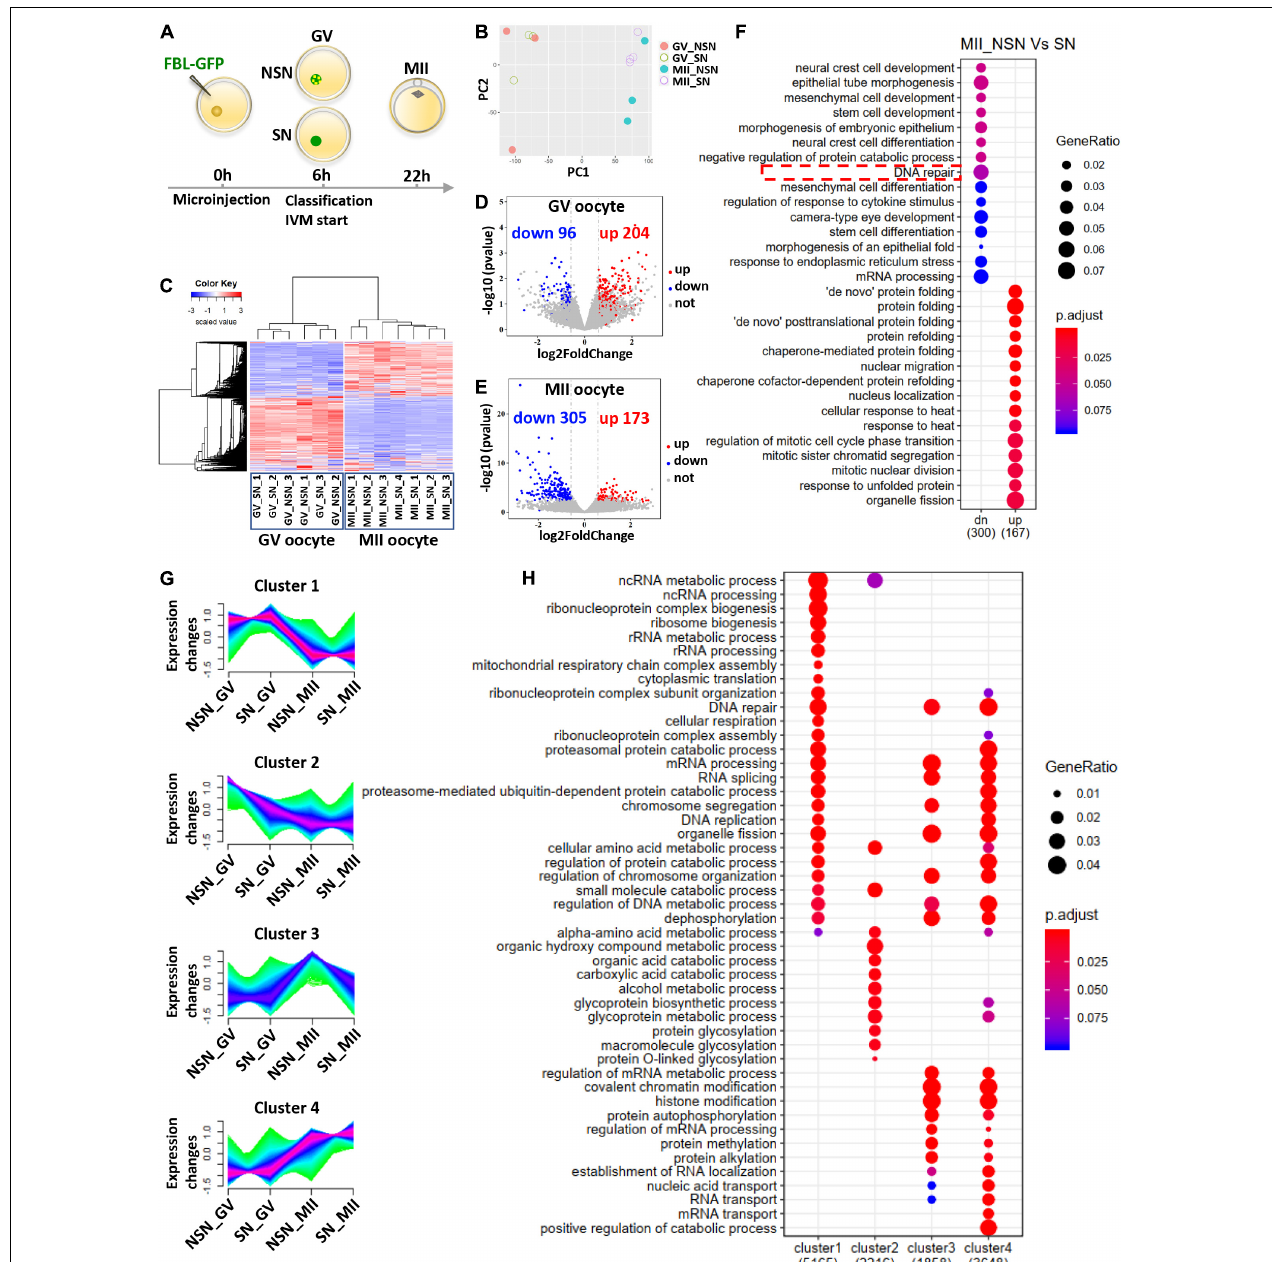
FIGURE 3 | Transcriptome comparison before and after meiotic maturation of NSN and SN oocytes. (A) Schematic illustrating the pipeline of preparing single oocyte RNA-Seq samples. (B) PCA analysis of RNA-Seq data from NSN and SN oocytes at the GV and MII stages. Each dot represents one library, color-coded by oocyte type and stage. (C) Gene expression heatmap of NSN and SN oocytes at the GV stage and MII stage. The blue to red color change represents the transcription level from low to high. (D,E) Volcano plot of DEGs in NSN oocytes vs. SN oocytes at the GV stage and MII stage. The upregulated (fold change > 1.5) and downregulated (fold change < –1.5) transcripts in each comparison are labeled by red and blue, respectively ( P < 0.05). (F) Gene ontology analysis of the upregulated and downregulated DEGs between NSN and SN MII oocytes. (G) Mfuzz analysis of RNA-Seq data from NSN and SN oocytes at the GV and MII stages. The x axis represents oocyte types and stages, while the y axis represents standardized FPKM. Green to purple colored lines correspond to genes with low to high membership value. (H) Gene ontology analysis of genes in the four clusters from (G) (see also Supplementary Tables 1–3 ).